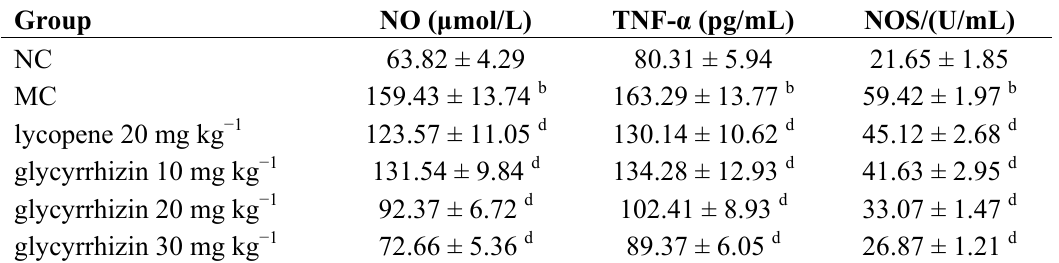
Table 4. Effect of glycyrrhizin treatment on blood NO, TNF- α levels and NOS activity. Group